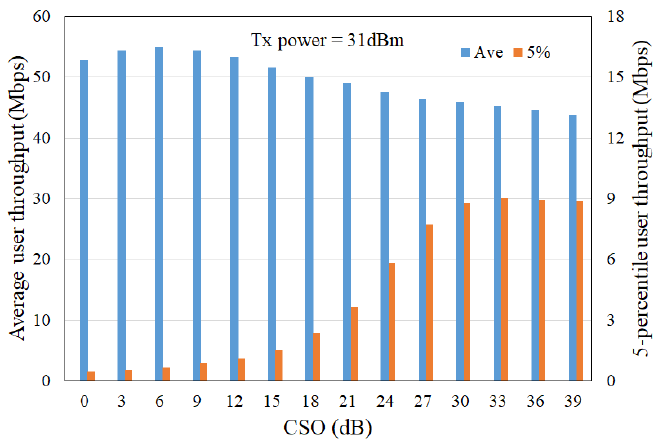
Figure 14. Average and 5-percentile user throughput as a function of CSO for pico-eNB Tx power of 31 dBm.